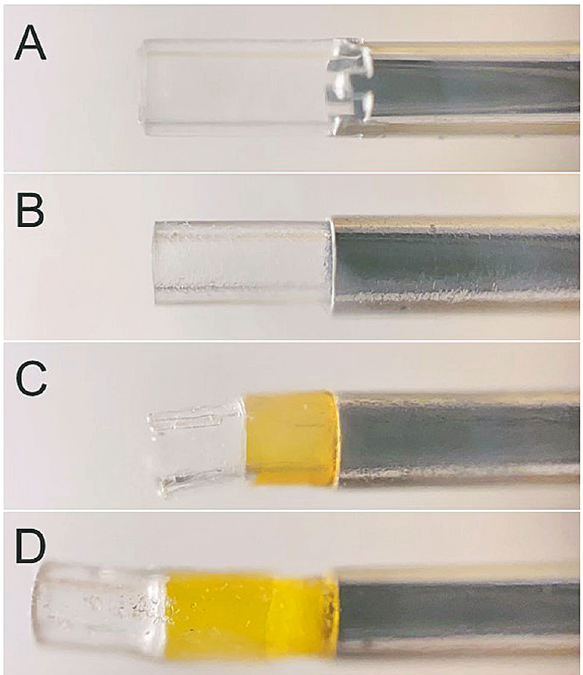
Figure 6. Magnified photographs of the joint between the silicon chip and the shaft in the 27G product from each manufacturer. The jointing method varied from company to company. The product from Company A (Alcon) had a structure in which a similarly processed silicon chip was fitted into the uneven metal part and the jointing surface was bonded with an adhesive ( a ). The products from Company C (VitreQ) ( c ) and Company D (DORK) ( d ) had a structure in which the shaft and the silicon chip were bridged and jointed by a tube of resin material. Detailed information was not available for the product from Company B (MedOne) ( b